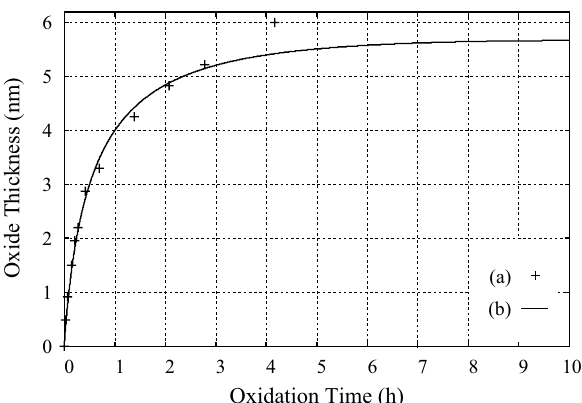
1.33 10 − 4 (Pa) 773 K and P O 2 = × = 0.83 and B 4.09 (nm), which are = =